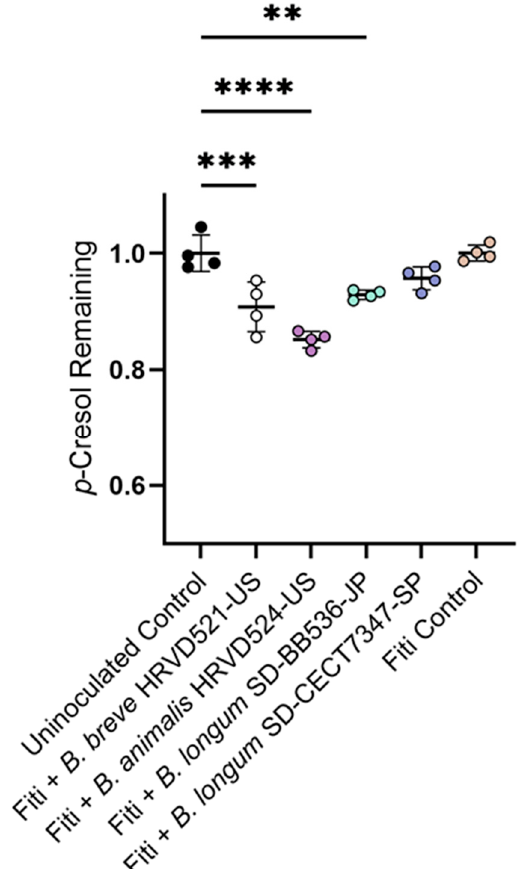
Figure 3. p -Cresol is depleted by probiotic bifidobacteria-containing yogurt within a mock colonic environment. Bacteria were cultured for 24 h in colonic medium spiked with 0.2 mg/mL p -cresol and the remaining toxin was quanti fi ed via HPLC ( n = 4). Data are displayed as the mean ± standard deviation (SD). Signi fi cance was determined by one-way ANOVA; ** p < 0.01; *** p < 0.001; **** p < 0.0001; ns, not signi fi cant.